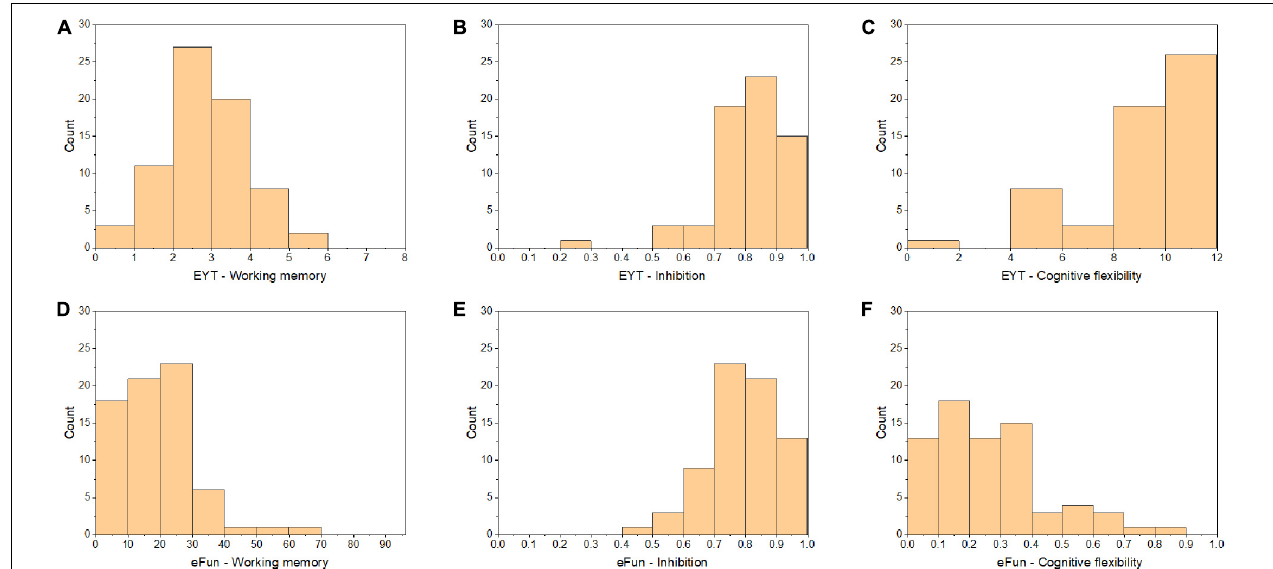
FIGURE 6 | Frequency histograms of student performance on (A) EYT – Working memory, (B) EYT – Inhibition, (C) EYT – Cognitive flexibility, (D) eFun Working memory, (E) eFun Inhibition, and (F) eFun Cognitive flexibility.